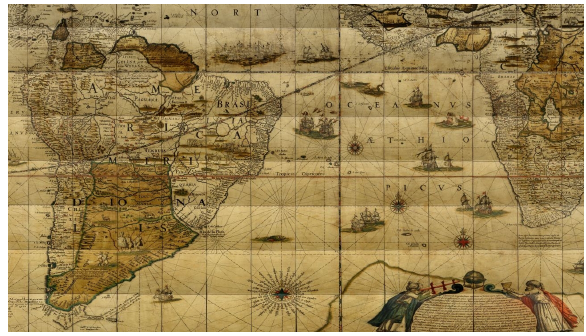
Figure 5. Consequence of wrong lighting conditions